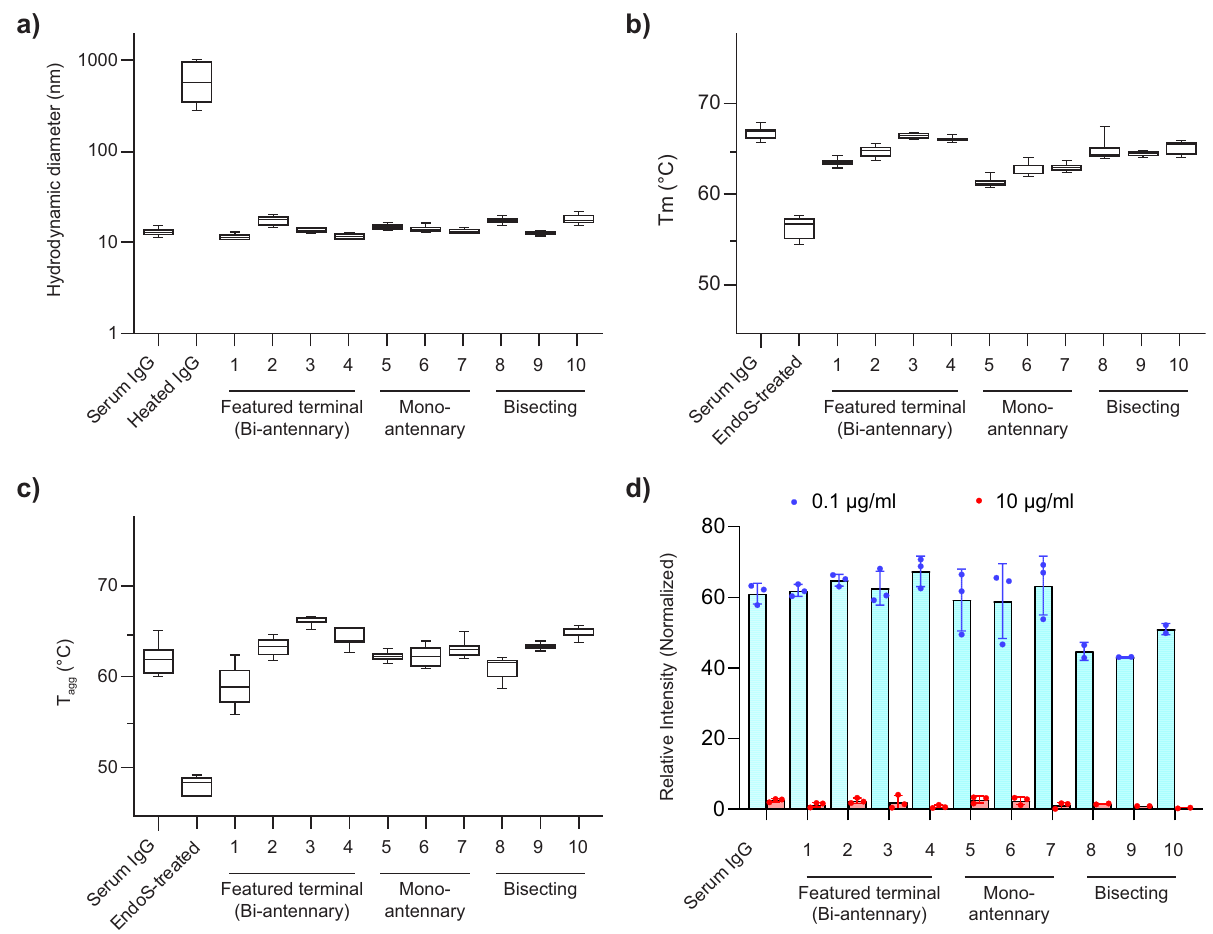
Fig. 5 Physical and biochemical characterization of SPGR-engineered IgGs. a Size analyses using dynamic light scattering (DLS). b Melting temperature analyses (T m ). c Aggregation temperature analyses (T agg ). Endo S treatment removed most IgG glycan structures, leaving only GlcNAc-Fucose di- saccharide on IgG. Box and whiskers graph: median with 25th to 75th percentile. whiskers indicate min and max values ( N = 5). d Competition assay revealed the binding af fi nity of SPGR-engineered IgG to Fc gamma receptor I (Fc γ R-I). The lower the relative intensity, the stronger the interaction between SPGR-engineered IgG and Fc γ R-I was. Refer to Fig. 3 and S12 for the chromatograms of analyzed